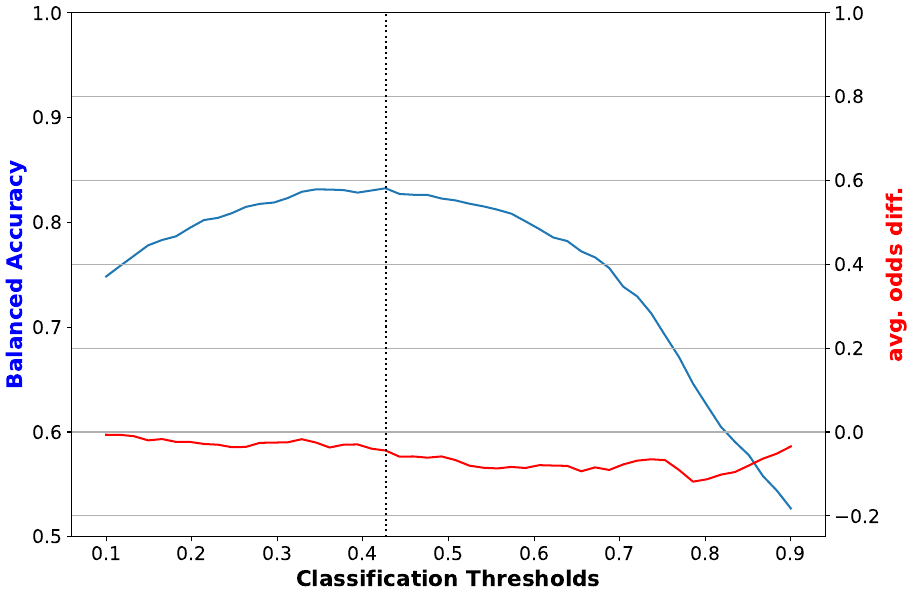
Figure 3. Balanced accuracy and average odds difference versus classification threshold for a logistic regression classifier with no bias mitigation. The dotted vertical line is the threshold that maximizes balanced accuracy. The plot shown corresponds to one of the folds of